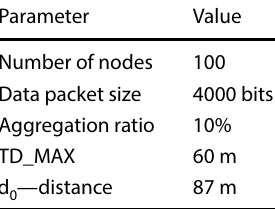
Table 1 Simulation specifications